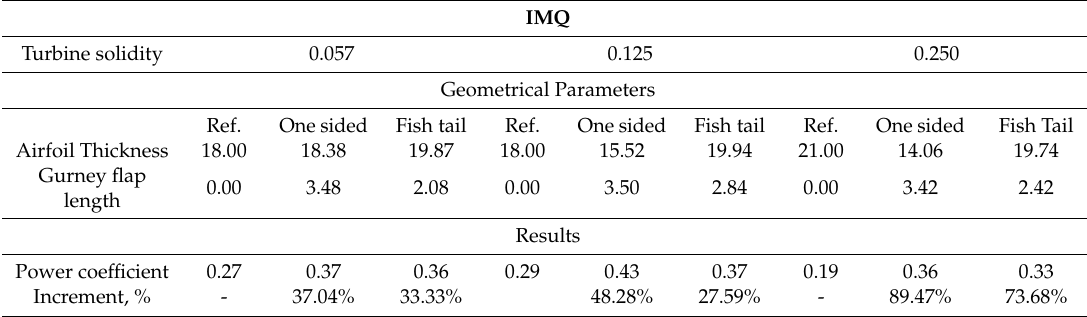
Table 4. Power coe ffi cient and geometrical parameters of the most e ffi cient turbine and the reference one using IMQ